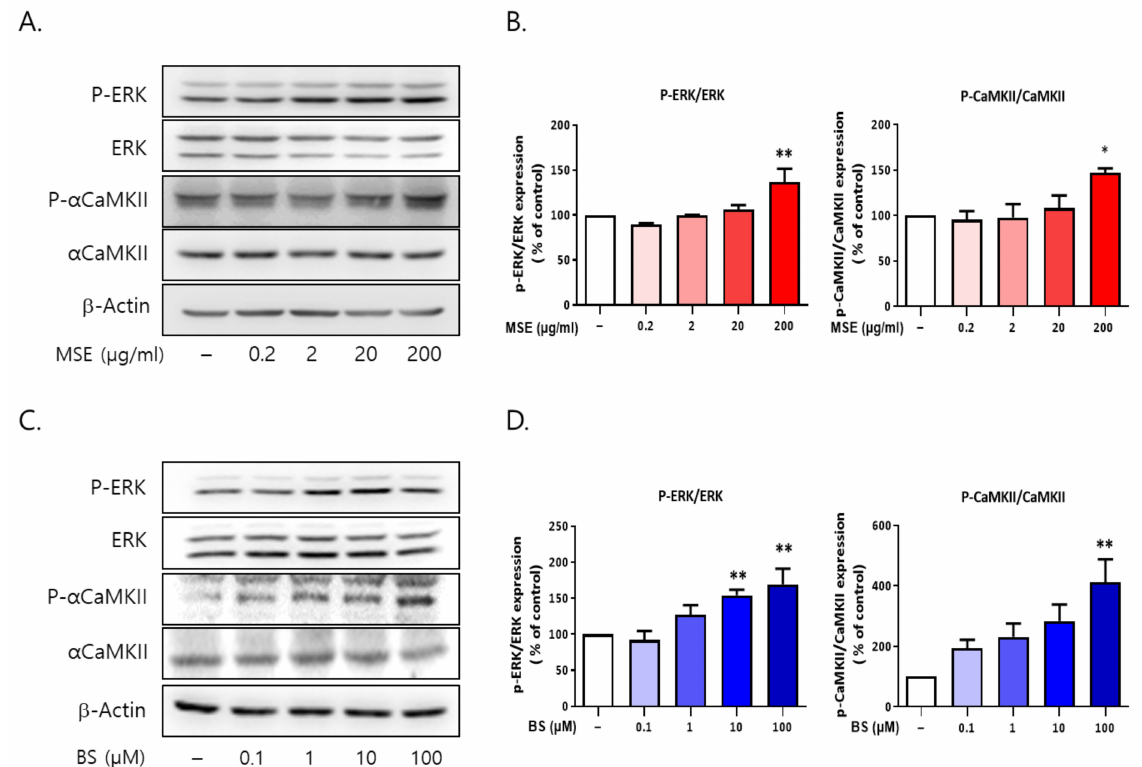
Figure 11. Maydis stigma activates the phosphorylation of ERK and α CaMKII in vitro. Cultured cortical neurons were treated with MS extracts (MSE; 0.2, 2, 20, 200 µ g/mL) and β -sitosterol (BS; 0.1, 1, 10,100 µ M). After 30 min, cells were harvested for measuring the protein expression of p-ERK and p- α CaMKII using Western blot. ( A , B ) p-ERK and p- α CaMKII phosphorylation by MSE treatment, ( C , D ) p-ERK and p- α CaMKII phosphorylation by BS treatment. * p < 0.05, ** p < 0.01; Veh vs. MSE and BS (N =